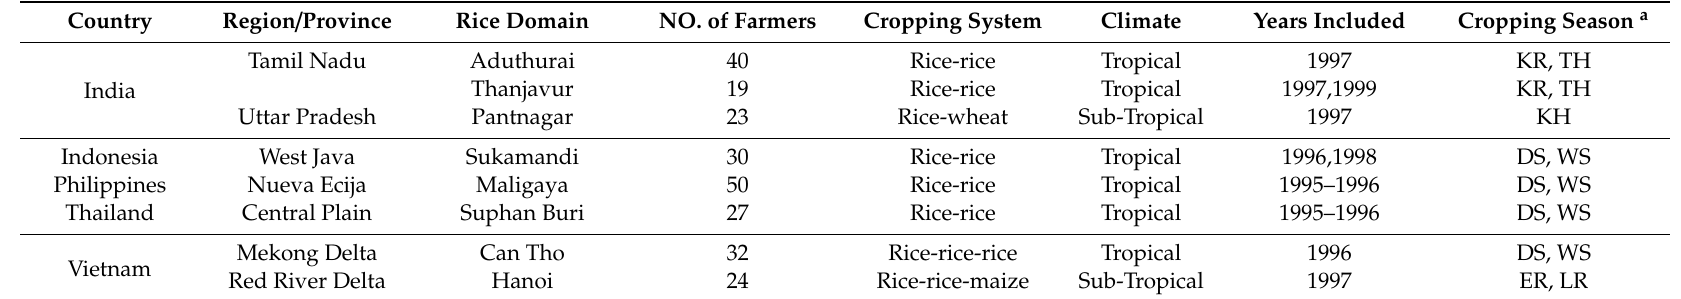
Table 1. Study area, RTDP,